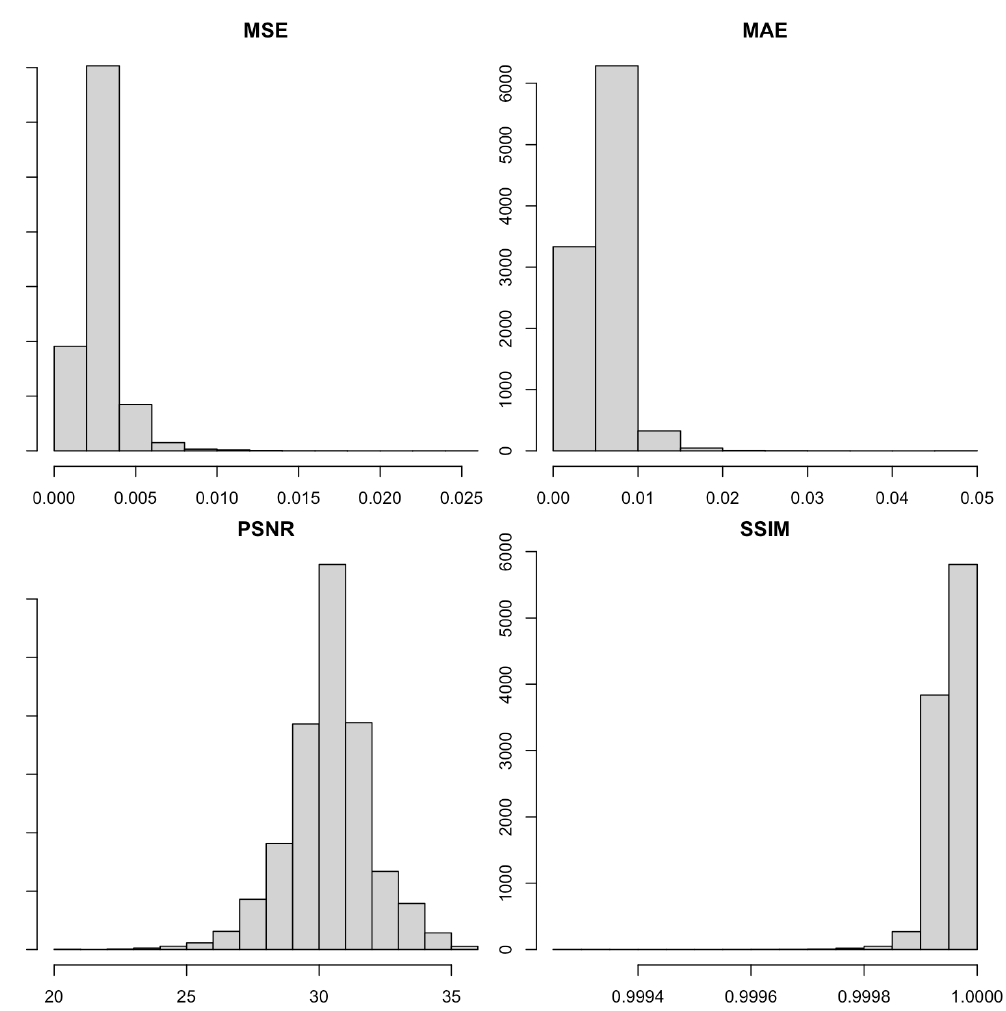
Figure 8. Statistical measures of reconstruction obtained with the use of the developed